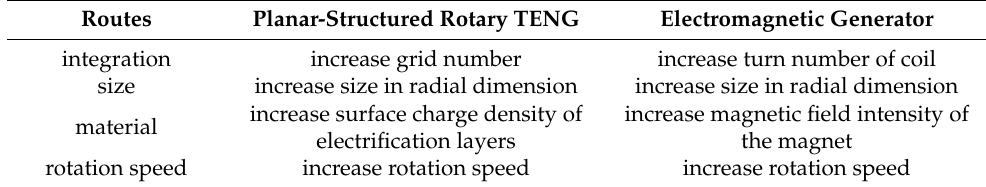
Table 1. Routes of improving generators’